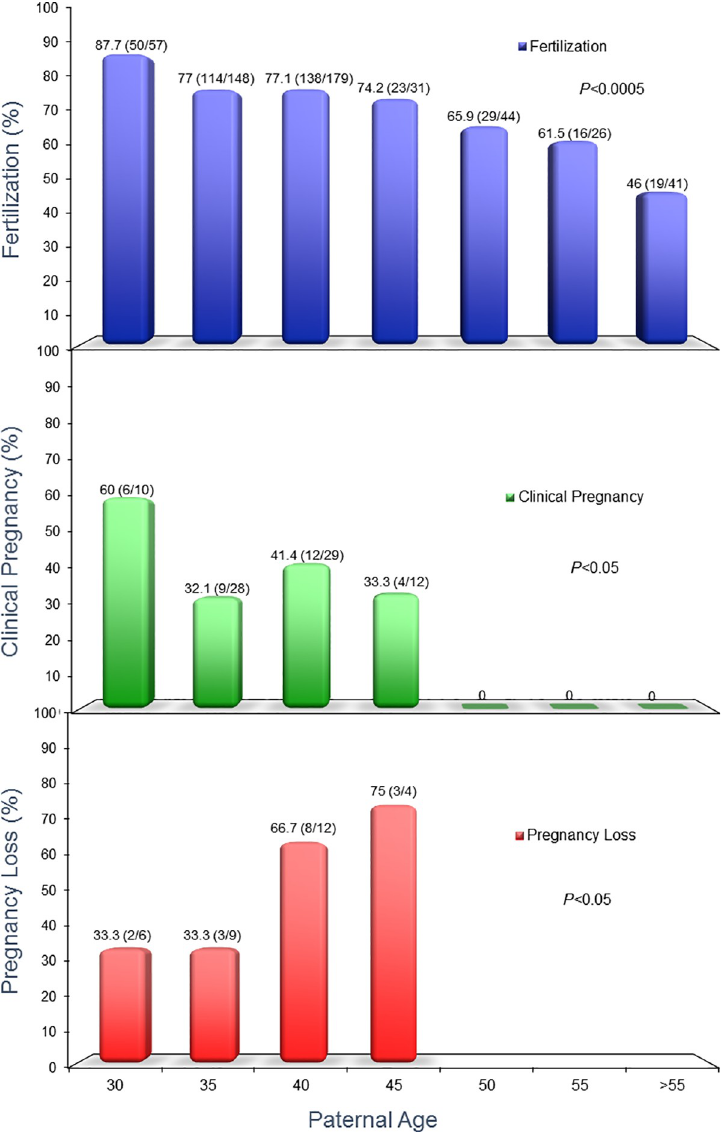
Fig 8. Fertilization, clinical pregnancy, and rate of pregnancy loss in relation to paternal age. ICSI outcome was assessed for men whom we performed a FISH assessment on. Fertilization was characterized by a decreasing trend and was lowest in the > 55 age group. Clinical pregnancy rates was highest in the 25–30 age group but became absent in the 51–55 and > 55 age groups. The rate of pregnancy loss was also characterized by an increasing trend with advancing paternal